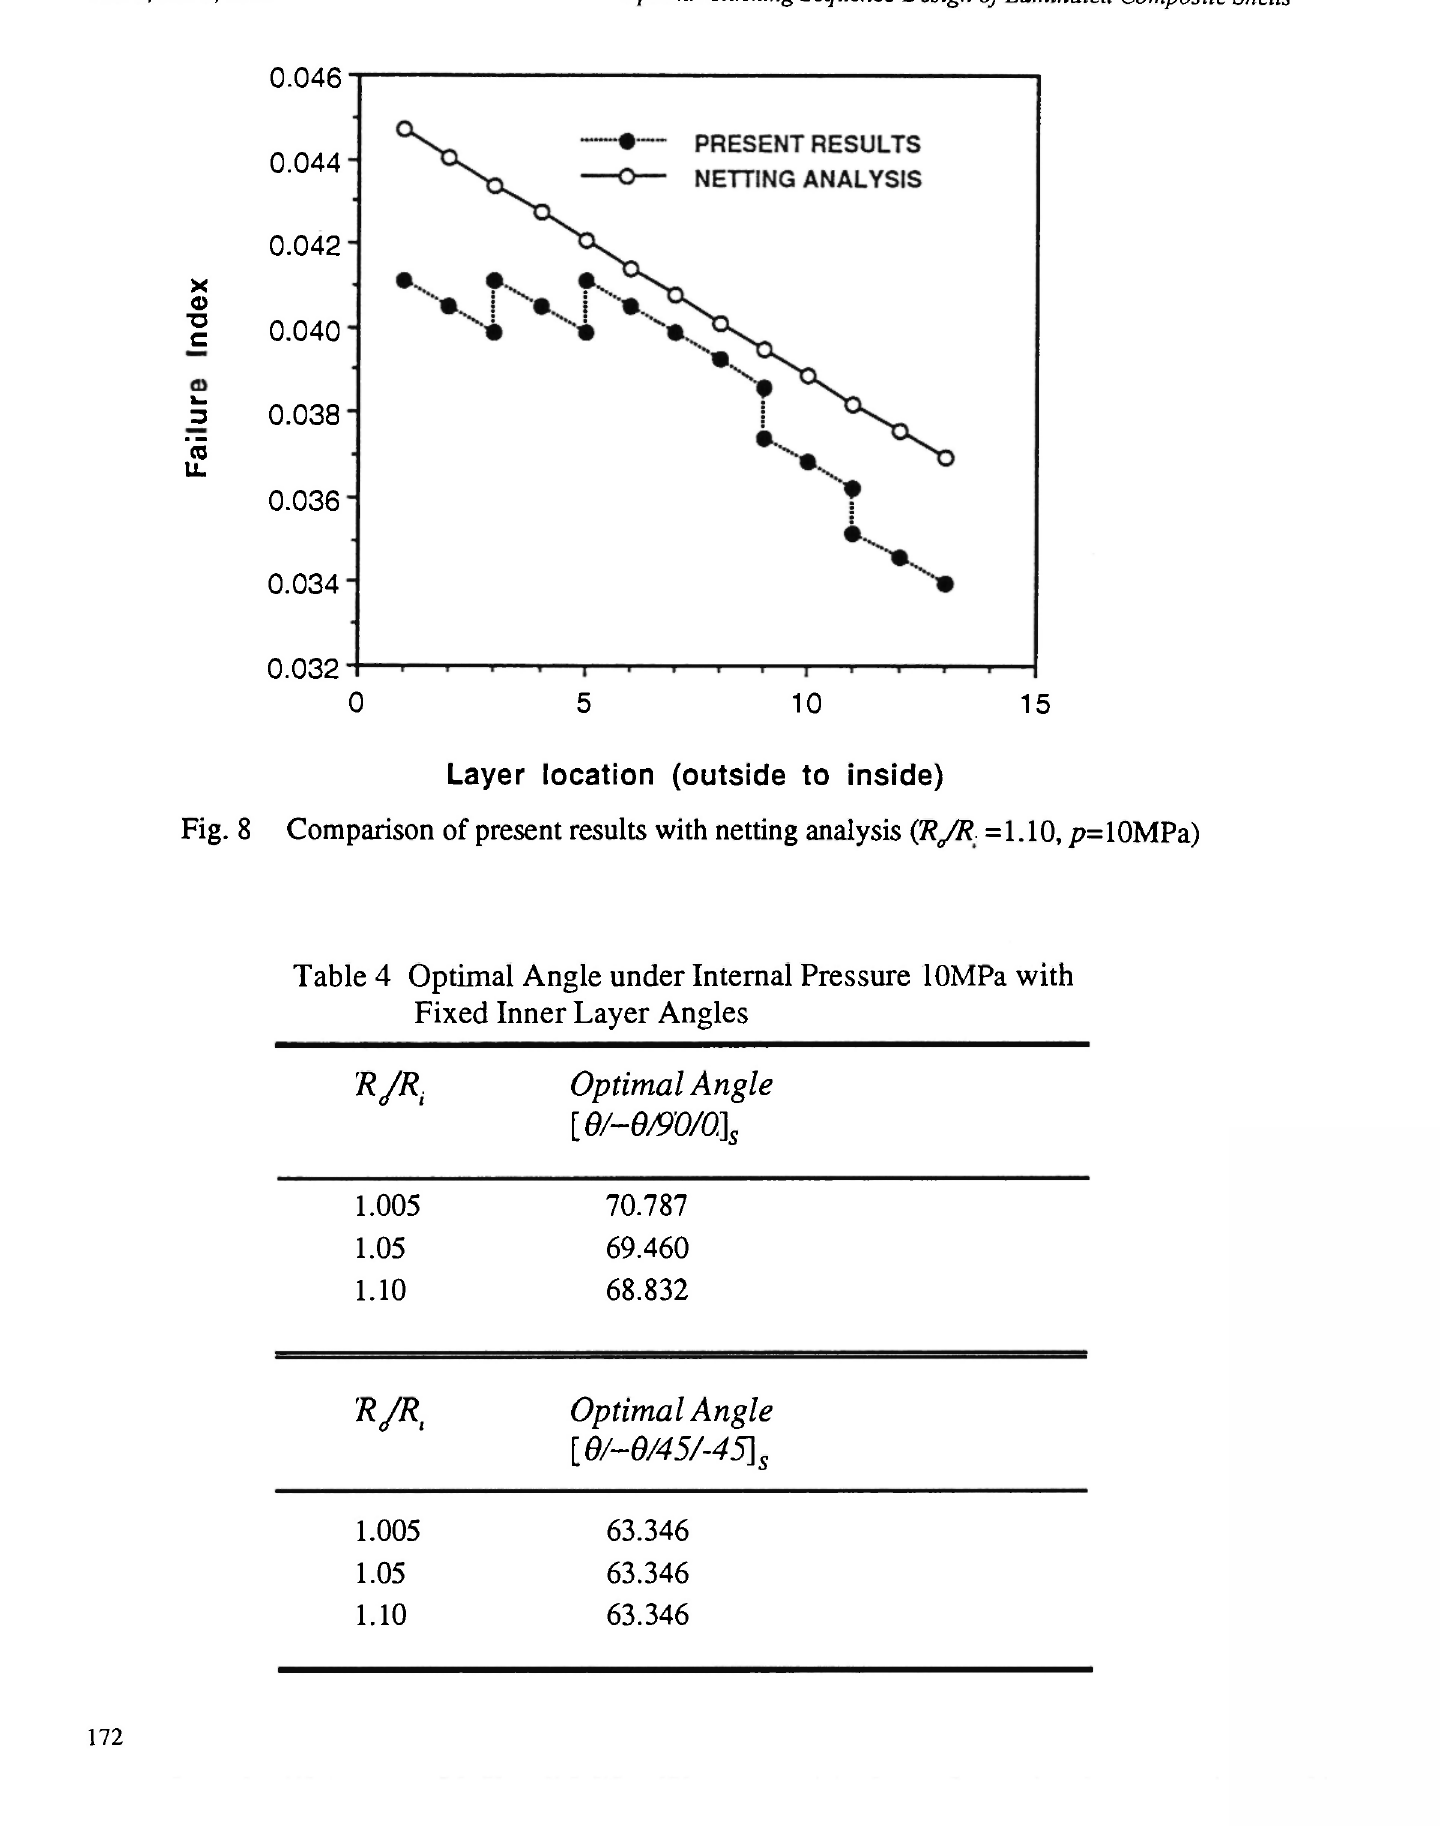
Comparison of present results with netting analysis (RJR'. =1.10, /?=10MPa)